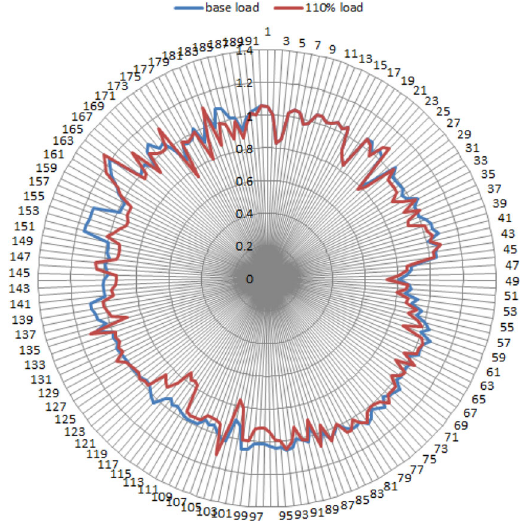
Fig. 11 Bus voltage profile under different loading conditions